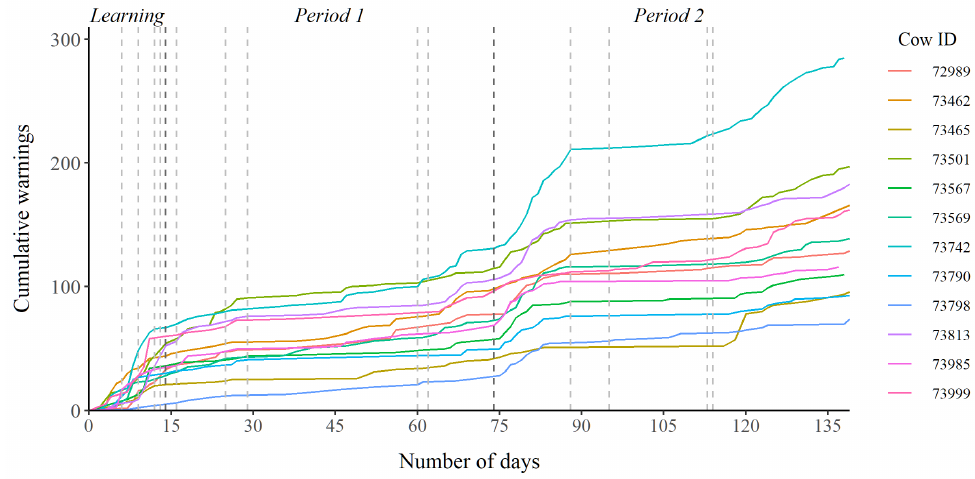
Figure A11. Cumulative number of warnings received by each cow during the three periods. The ver- tical lines in the plot mark any significant change in the virtual enclosure, where the darker lines indicate the division of the three periods. Excluding days where a social panic reaction